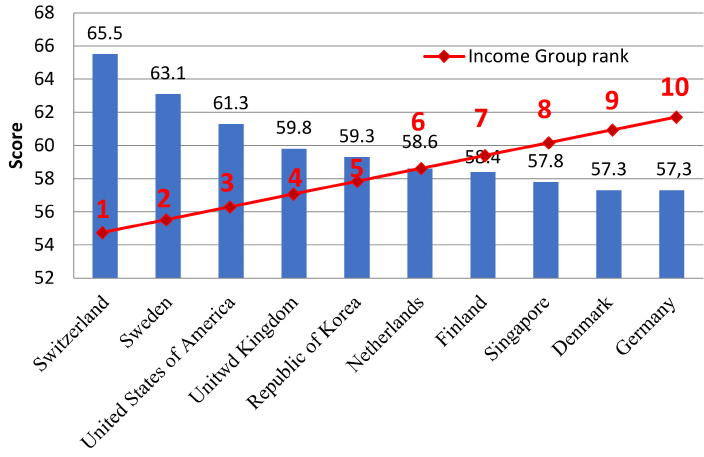
Figure 2. Top ten countries according to the GII-2021 Global Innovation Index. Reproduced with permission from [38]. Copyright 2021, World Intellectual Property Organization.